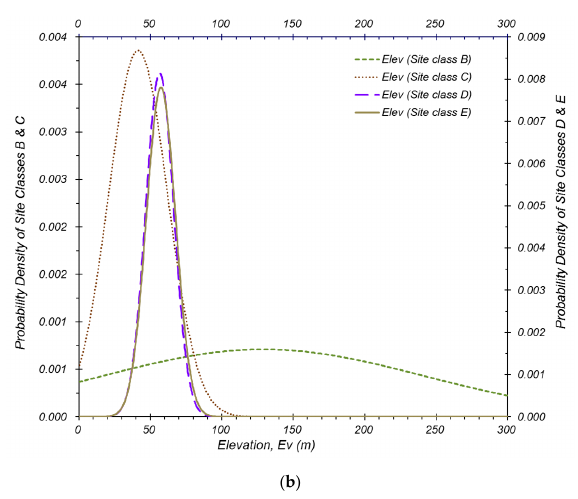
Figure 6. Logarithmic normal probability distribution of geo-proxies for each site classification condition according to V S 30 in Seoul: ( a ) surface terrain slope; ( b ) surface elevation.